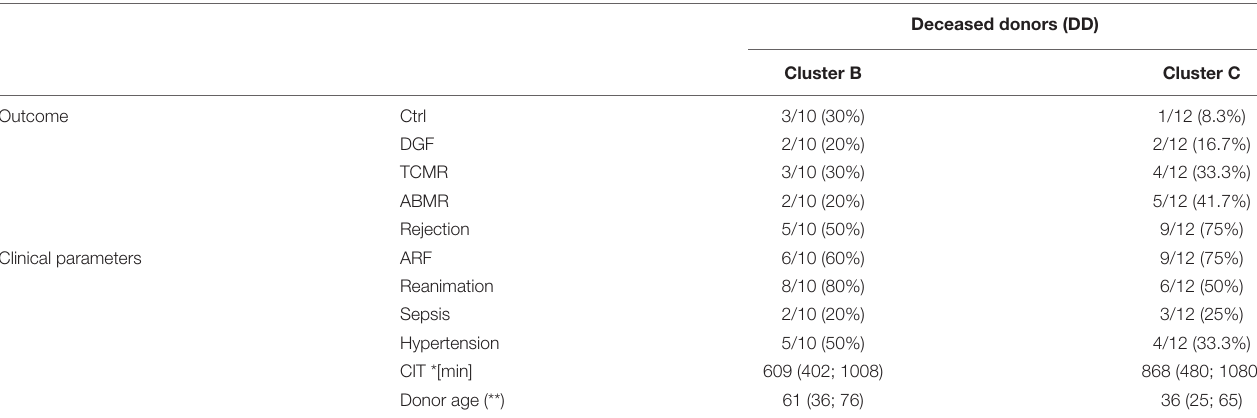
TABLE 4 | Distribution of outcome and clinical parameters of samples belonging to the two DD clusters (B, C) of Figure 2